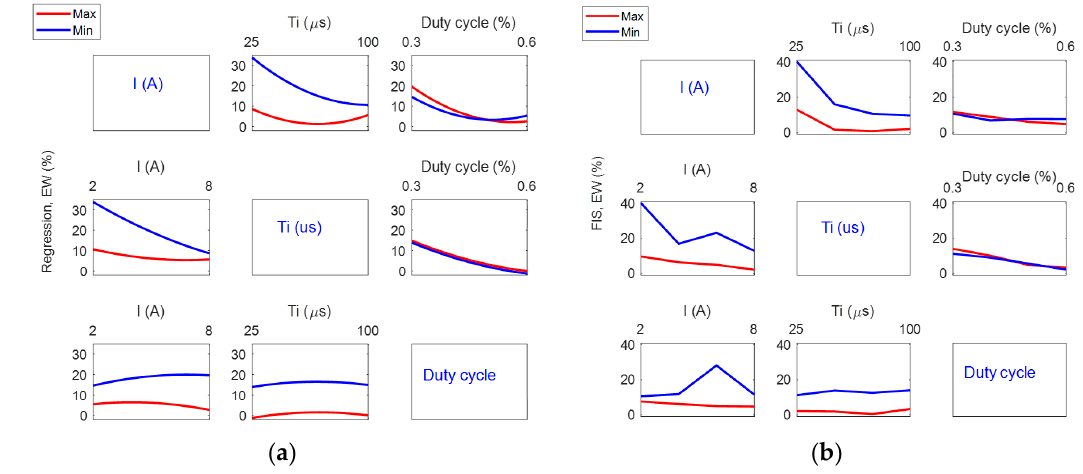
Figure 12. Interaction effects plot for EW in the case of positive polarity: ( a ) obtained from the regression [2]; ( b ) obtained with the proposed methodology using the FIS.